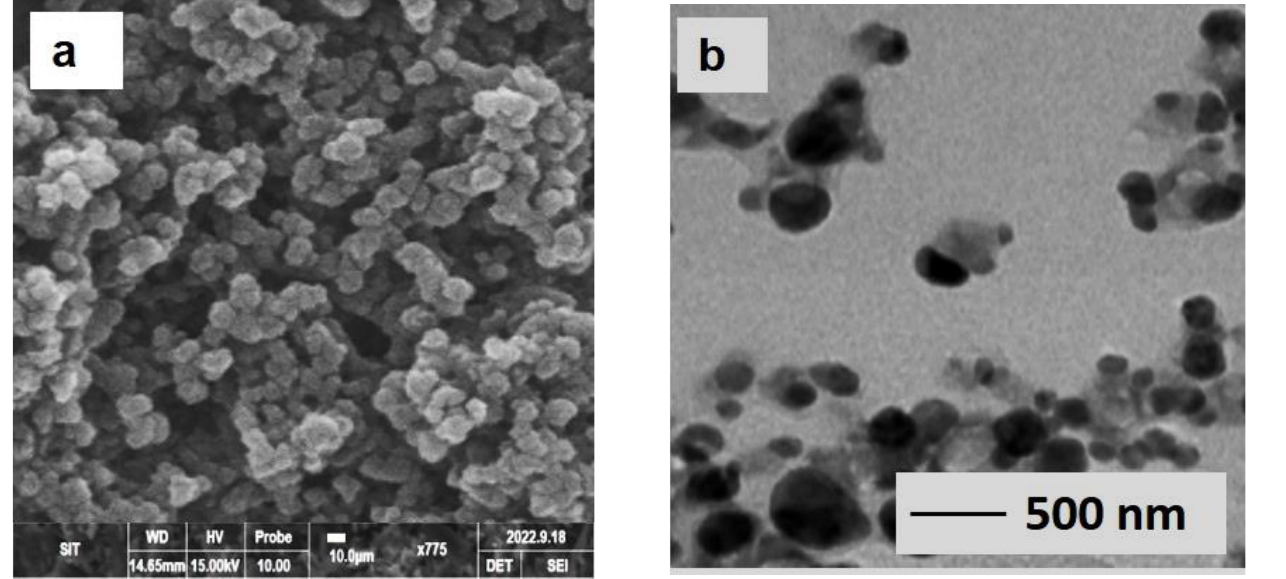
Figure 4. Microstructural analysis of ( a ) SEM images of Al 2 O 3 NPs; ( b ) TEM Images of spherical structured nanoparticles.